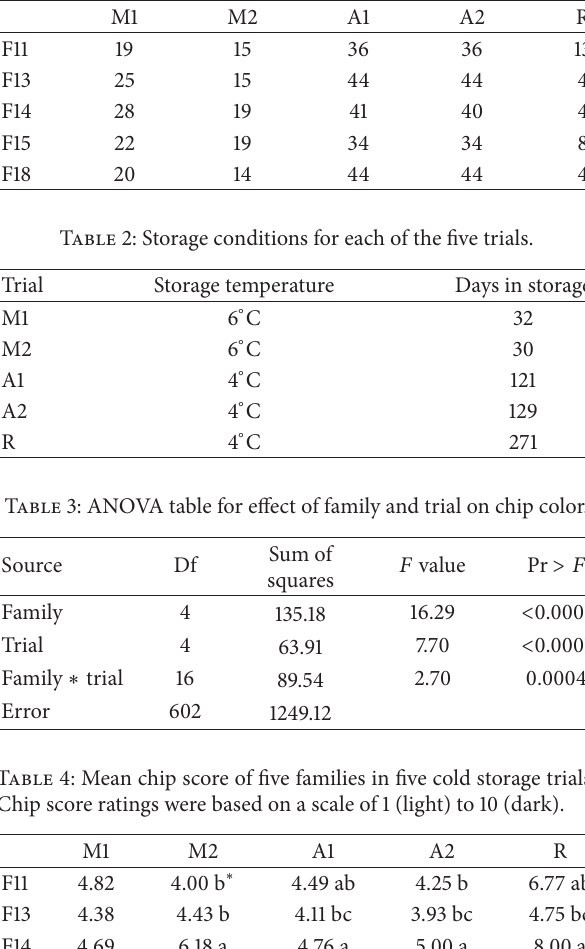
Table 1: Number of clones evaluated for chip color in five families (F11–F18) across five trials (M1–R).